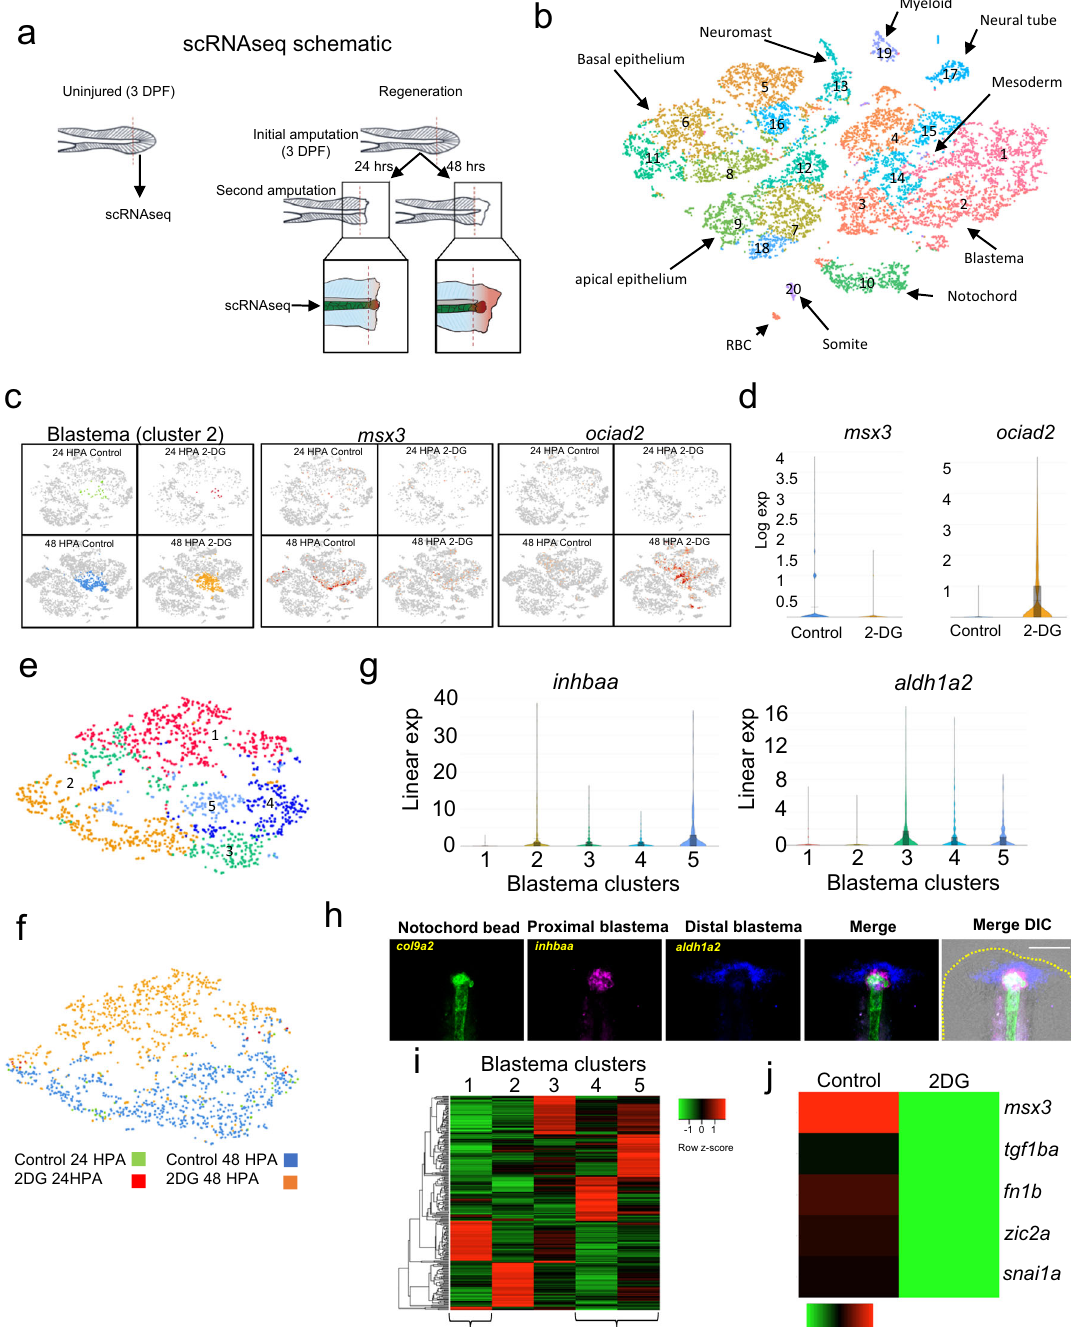
Fig. 4 2-DG prevents formation of normal blastema. a Illustration depicting the region of uninjured and regenerating tail taken for scRNA- seq. b t-SNE plot generated from Louvain clustering of cells from the scRNA-seq data. Number indicates cluster number. c Expression of msx3 and ociad2 transposed onto the t-SNE plot of cells from the scRNA-seq, shown by library. d Violin plots of msx3 and ociad2 expression in control and 2-DG treated blastemas (cluster 2). e t-SNE plot of reclustered blastema. Numbers indicate cluster number. f t-SNE plot of blastema clusters depicted by library. g Violin plots of inhbaa and aldh1a2 expression in the reclustered blastema clusters. h RNA-FISH images of col9a2 , inhbaa , and aldh1a2 , which depict the notochord / notochord bud, proximal blastema and distal blastema, respectively, in a 48 HPA embryo. Yellow dashed line indicates outline of tail. Scale bar = 100 µm. i Heatmap of marker genes for each reclustered blastema cluster. Cluster 4 and 5 are almost exclusively comprised of untreated control cells while cluster 1 is almost exclusively comprised of 2-DG treated cells. j Heatmap of expression of mesenchymal and blastema genes suppressed by 2-DG